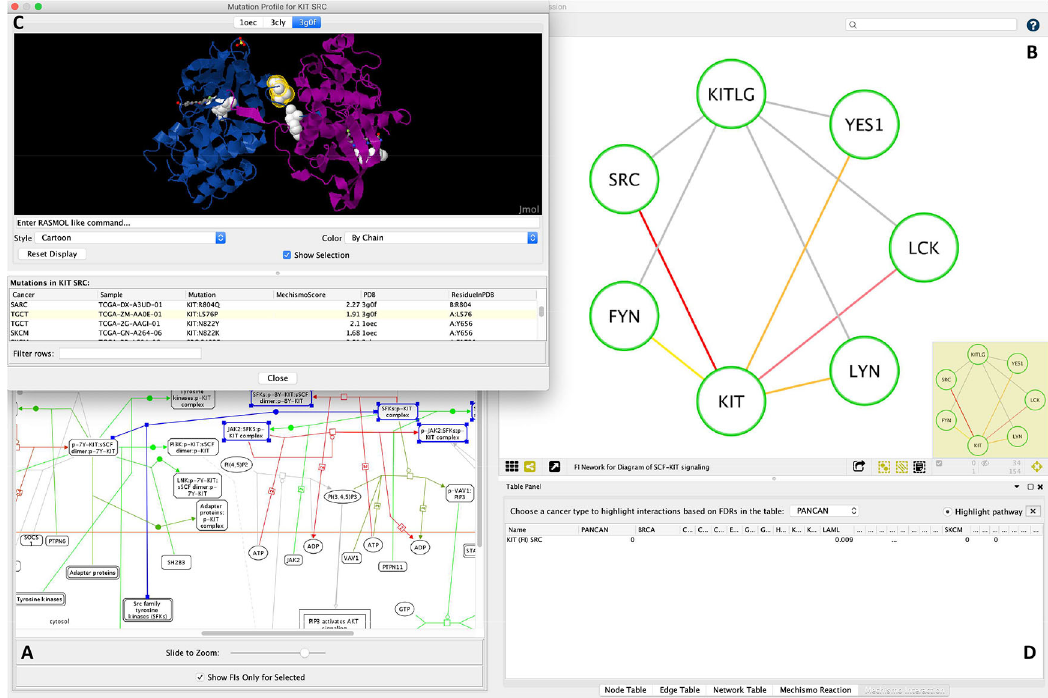
Figure 7. Visualization of structural variants in the context of Reactome pathways, reactions and functional interactions. A. Pathway diagram with reactions highlighted according to p-values from the structural analysis; B. Functional interactions for the selected reaction in A (in blue) with interactions highlighted according to p-values; C. Protein-protein interaction 3D view with mutation locations displayed in balls; D. Table control for users to choose a specific cancer to visualize its analysis